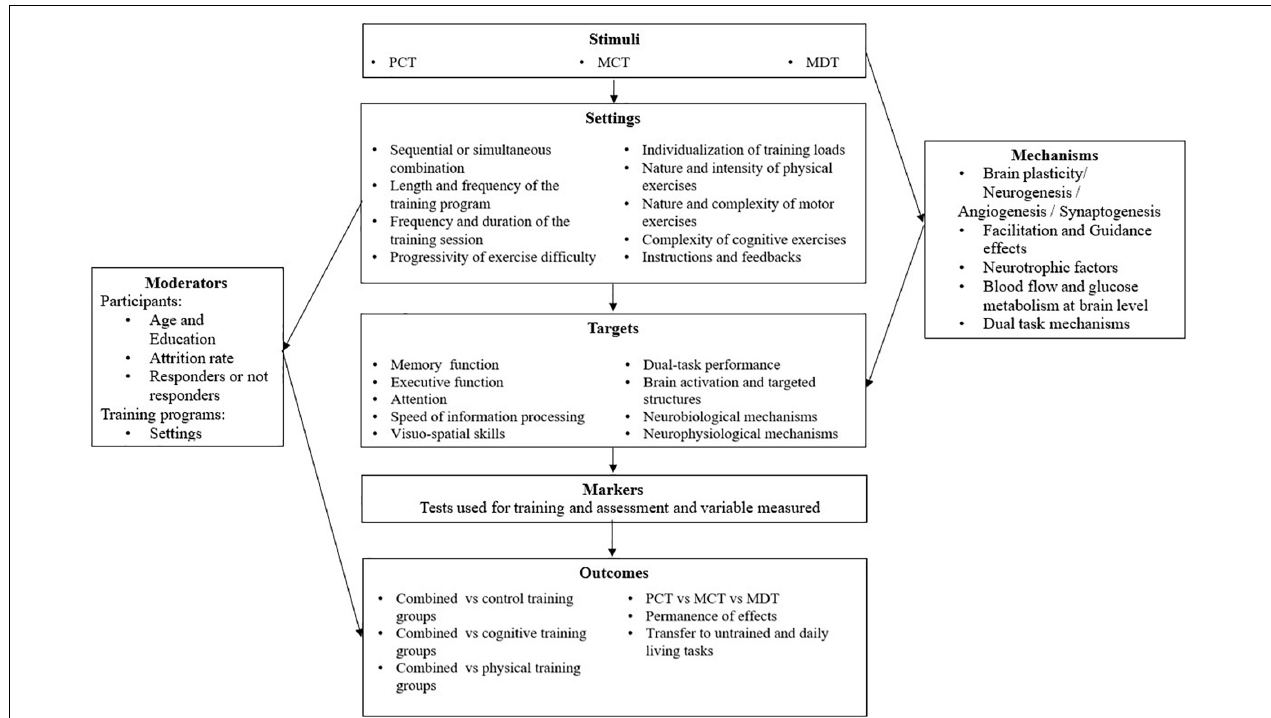
FIGURE 4 | The multi-dimensional analysis of combined training filled with a brief summary of the findings of the present